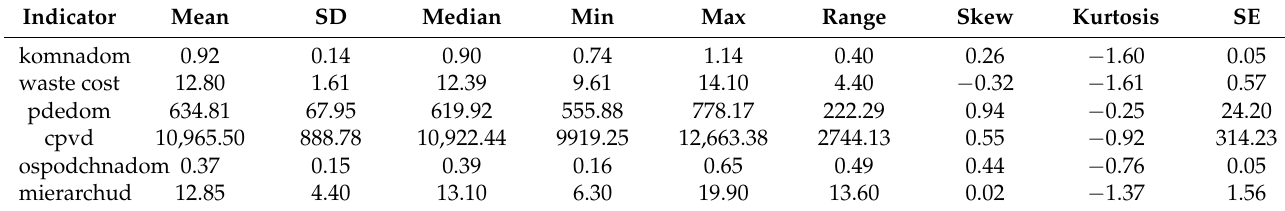
Table 8. Description characteristics in 2012.